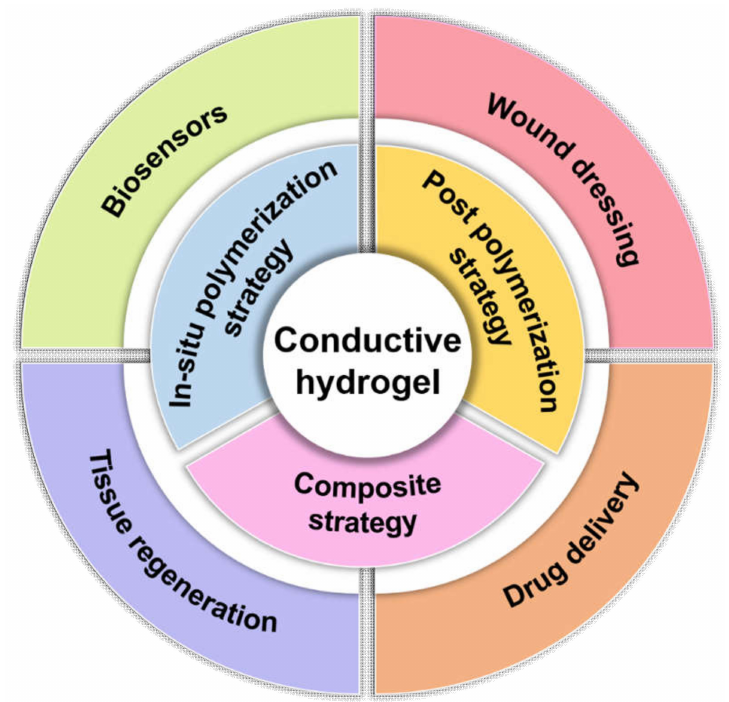
Figure 1. Summary for the design strategies and biomedical applications of conductive